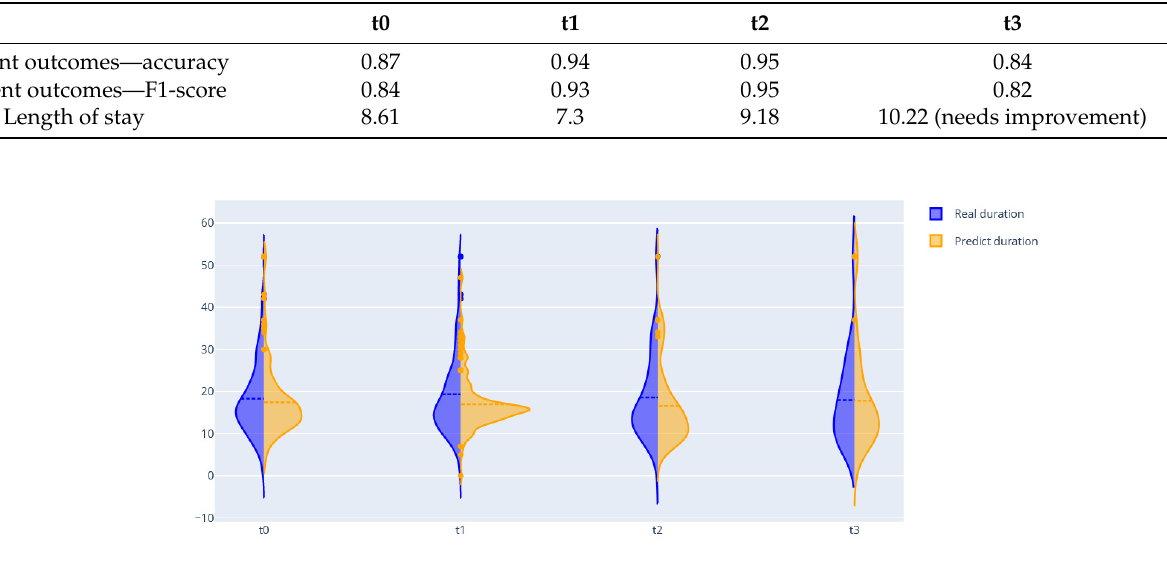
Figure 8. DAG for DBN for predicting treatment outcomes and length of stay.